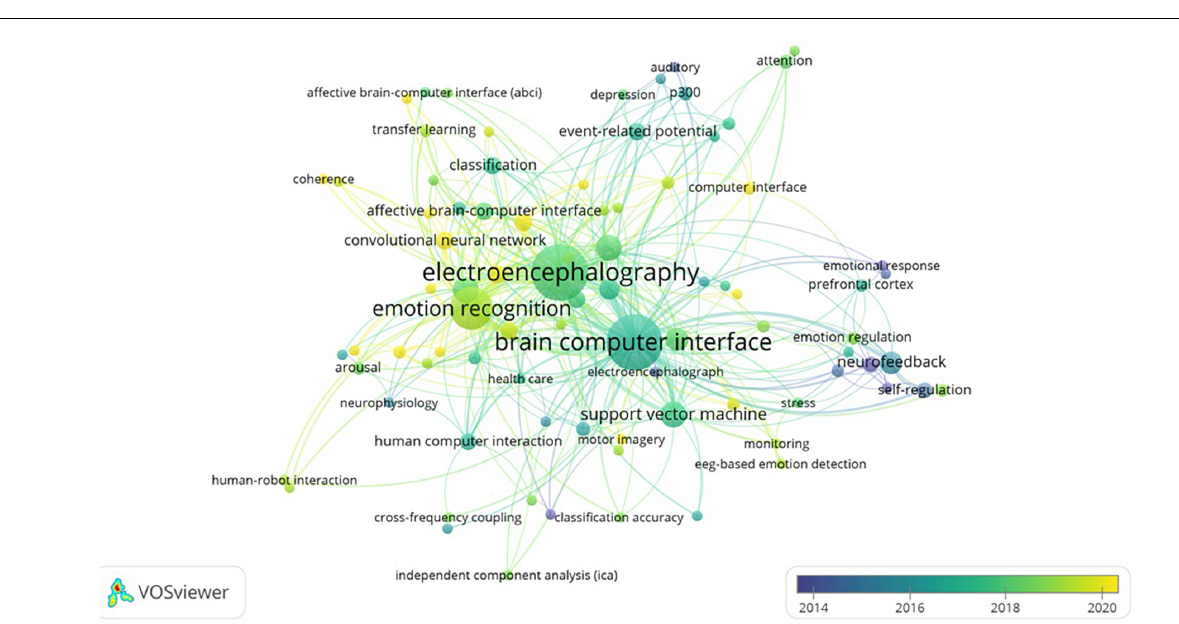
FIGURE 6 | Map of research